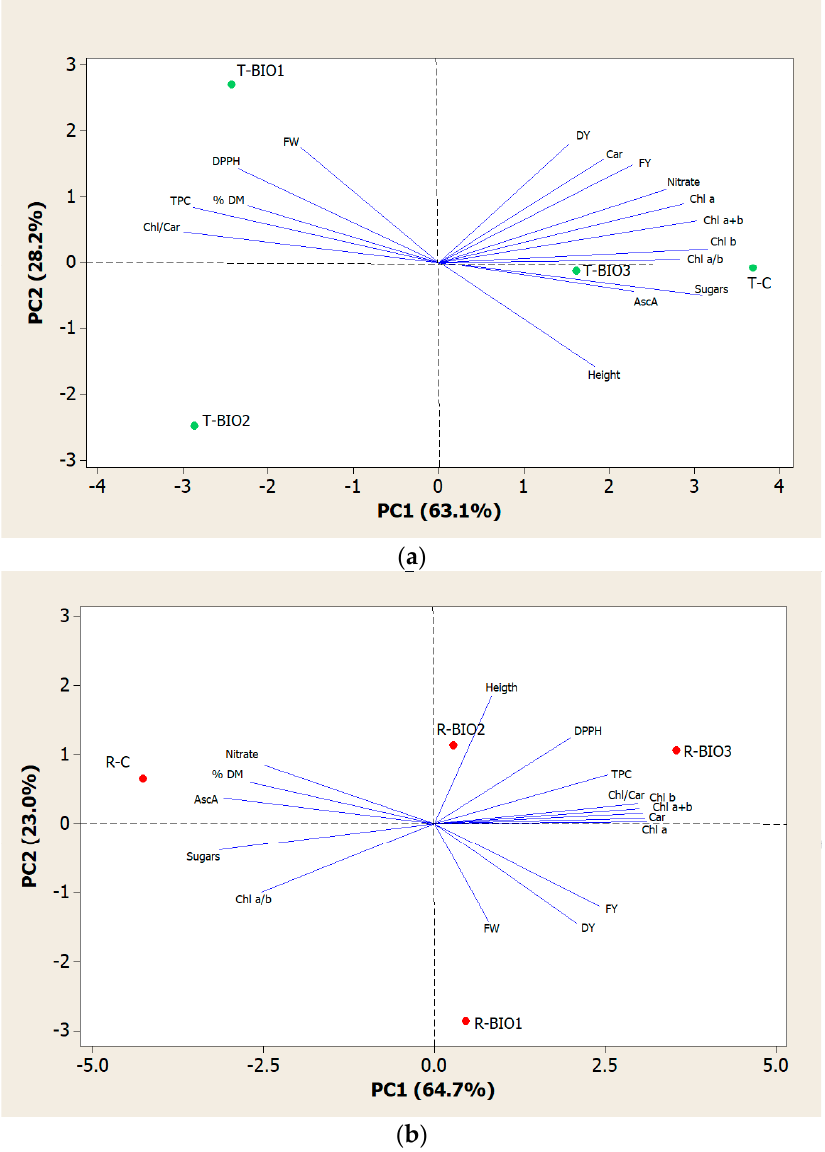
Figure 8. Principal component loading plot and scores of PCA for fresh and dry biomass yield (FY and DY), single seedling fresh weight (FW), dry matter percentage (% DM), seedling height, photosynthetic pigments (Chl a , Chl b , total Chl, carotenoids), total sugars, nitrates content, AscA, TPC, DPPH, for turnip greens ( a ) and radish ( b ) as modulated by treatments with biostimulants.